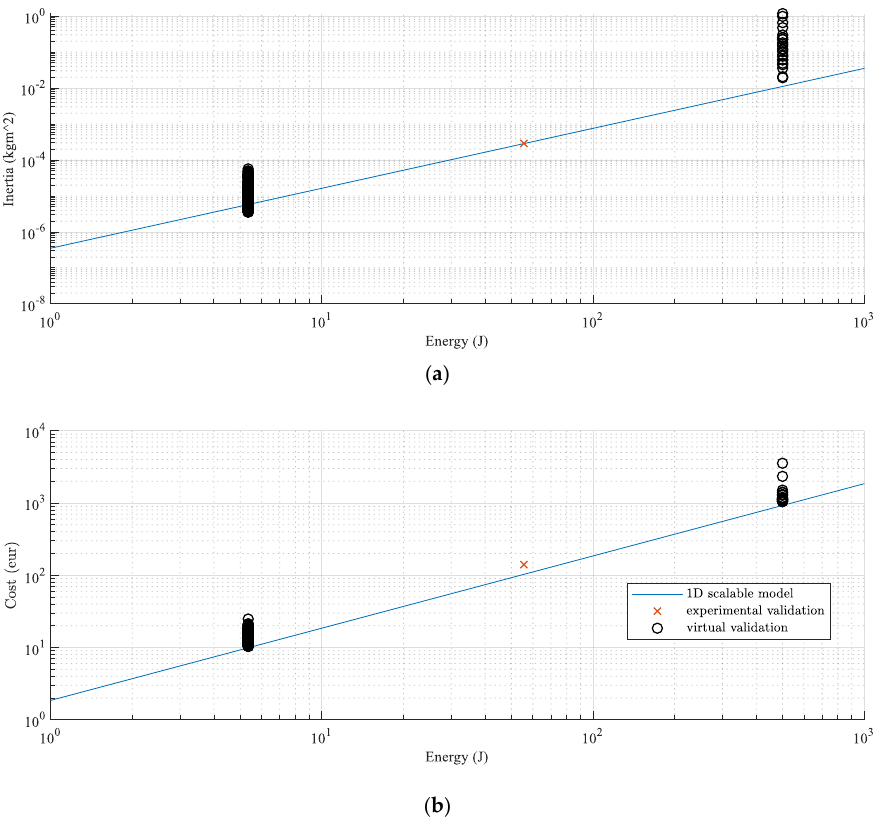
Figure 12. Validation of 1D scaling model for ( a ) magnetic spring inertia and ( b ) magnetic spring bulk material cost using experimental data and virtual validation data